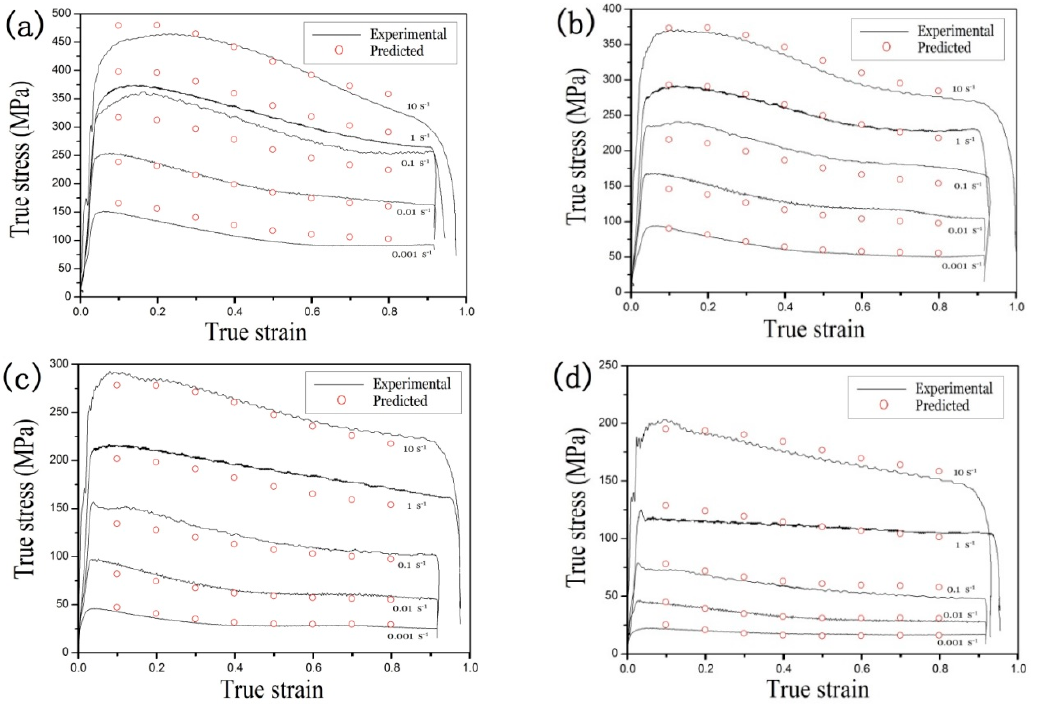
Figure 9. Comparison between the experimental and predicted flow stress at the temperature: ( a ) 1073 K, ( b ) 1123 K, ( c ) 1173 K, and ( d ) 1223 K.